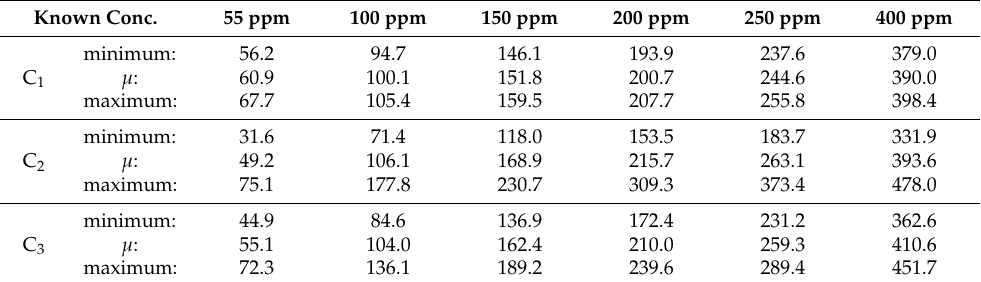
Table 6. Associated results to Figure 13.